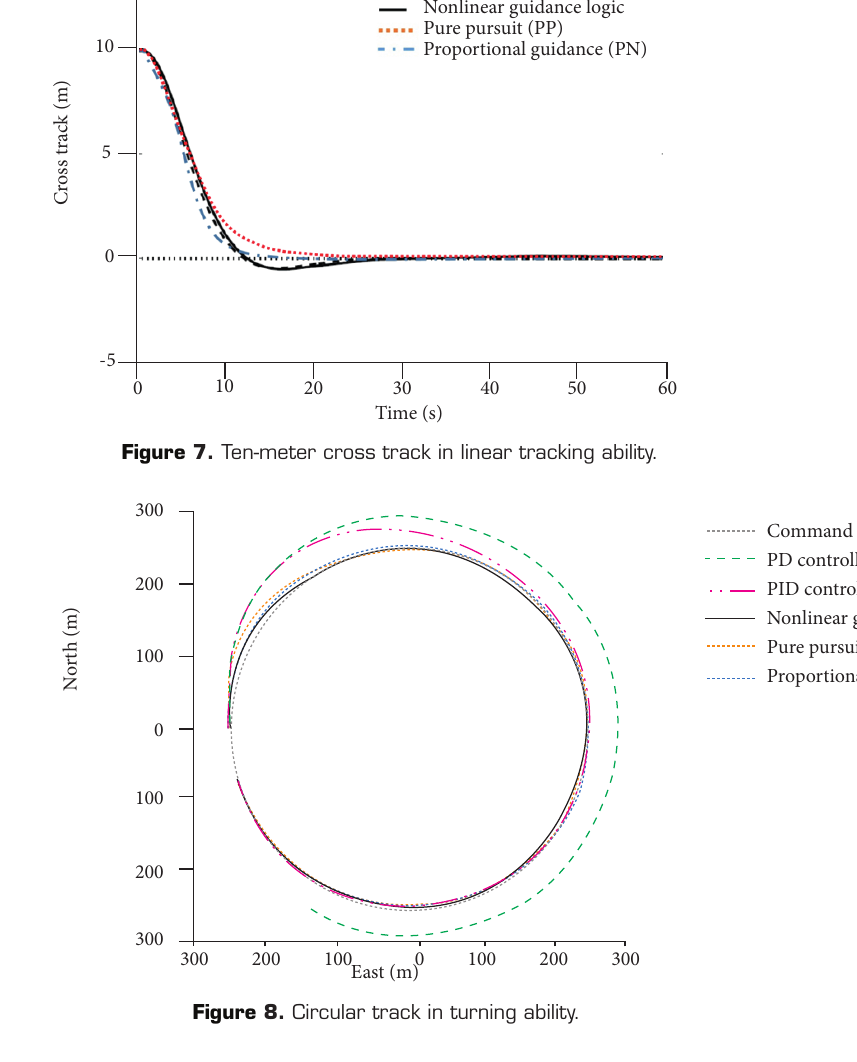
value (without noise) of performance parameters (tracking trajectory, leader tracking and …), is the average of X during Table 1. Tracking error due to control parameter error.